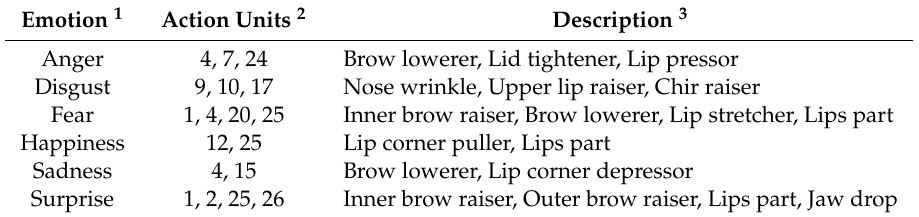
Table 1. Prototypical action units (AUs) observed in each basic emotion category